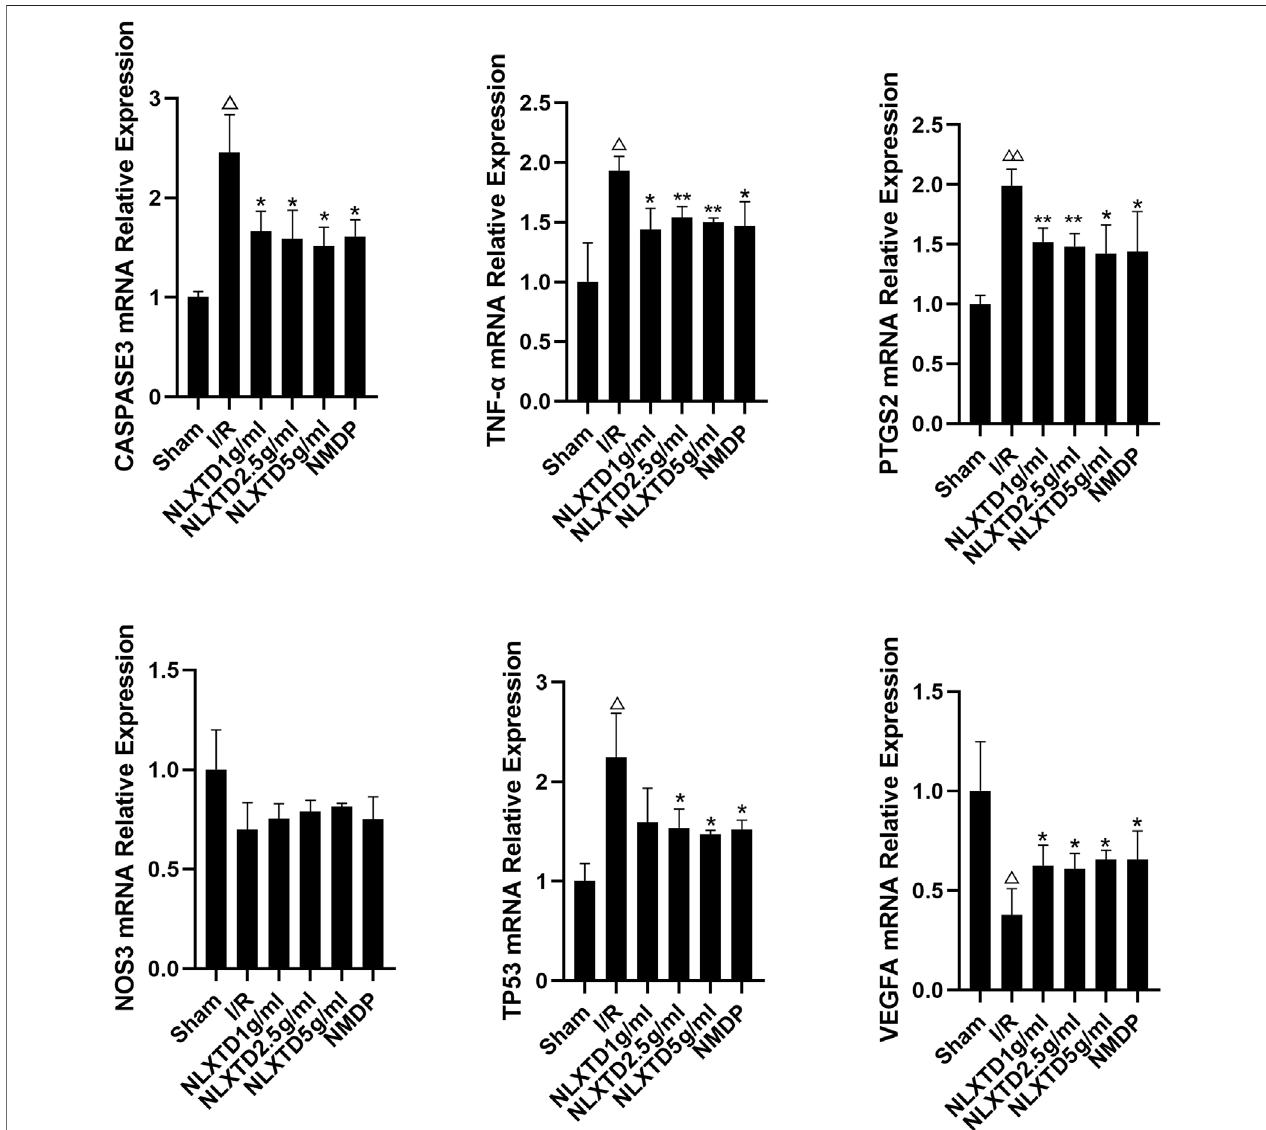
FIGURE7| mRNAexpressionofCASP3,TNF,PTGS2,TP3,NOS3andVEGFA.Notes: △△ p < 0.01, △ p < 0.05vs.Shamgroup;** p < 0.01,* p < 0.05vs.I/Rgroup ( n =